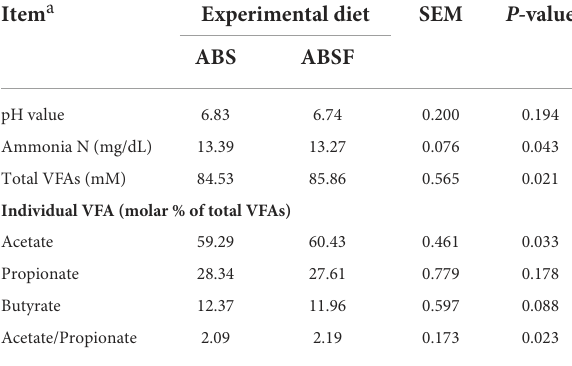
TABLE 3 Blood biochemical indices of goats fed a total mixed ration supplemented with anthocyanin-rich black cane silage (ABS) or anthocyanin-rich black cane silage treated with ferrous sulfate heptahydrate (ABSF).